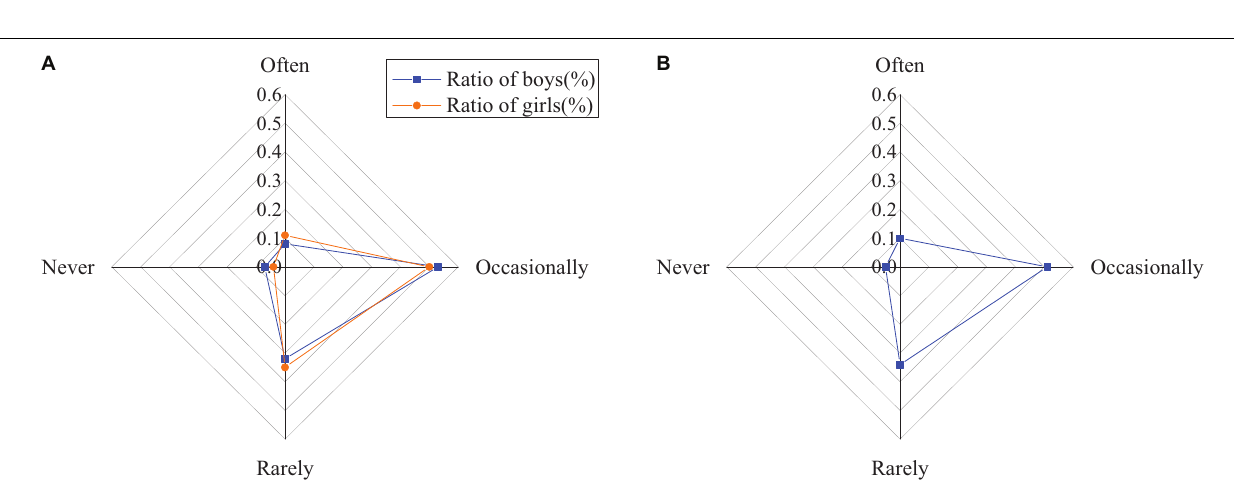
Frontiers in Psychology |